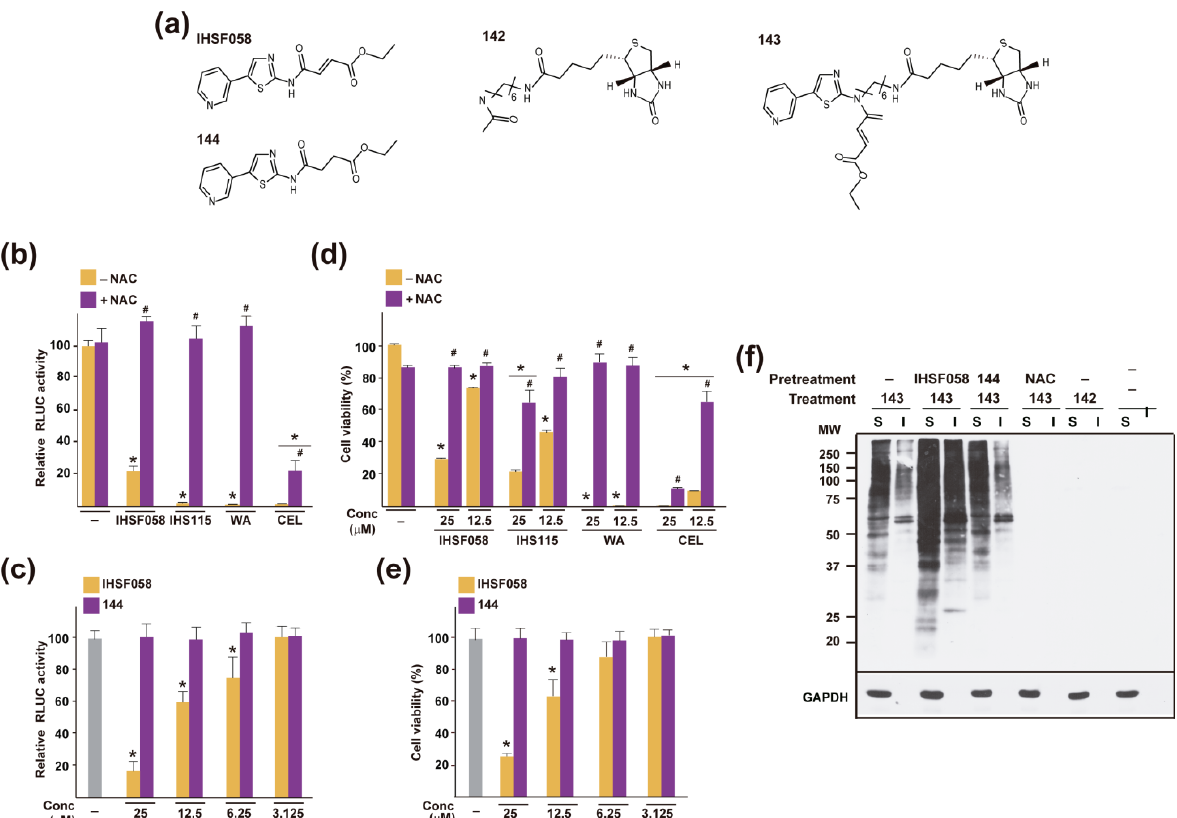
Figure 4. Thiol reactivity of IHSF, CEL and WA, and covalent modification of proteins by bioti- nylated IHSF058. ( a ) Structures of IHSF058 and compounds 142 – 144. ( b ) Parallel cultures of